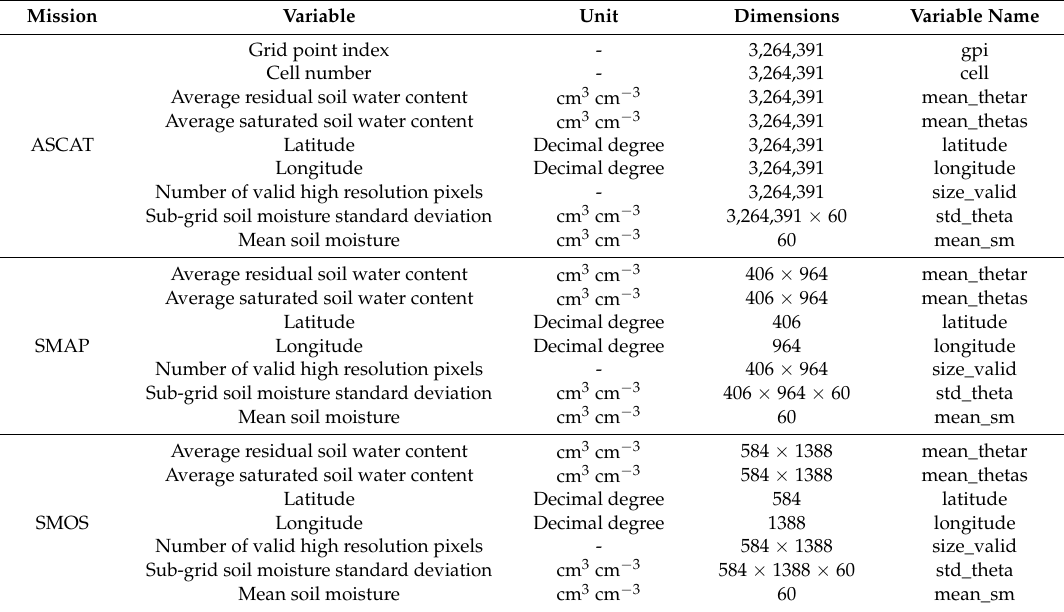
Table 1. Variables stored in the final data